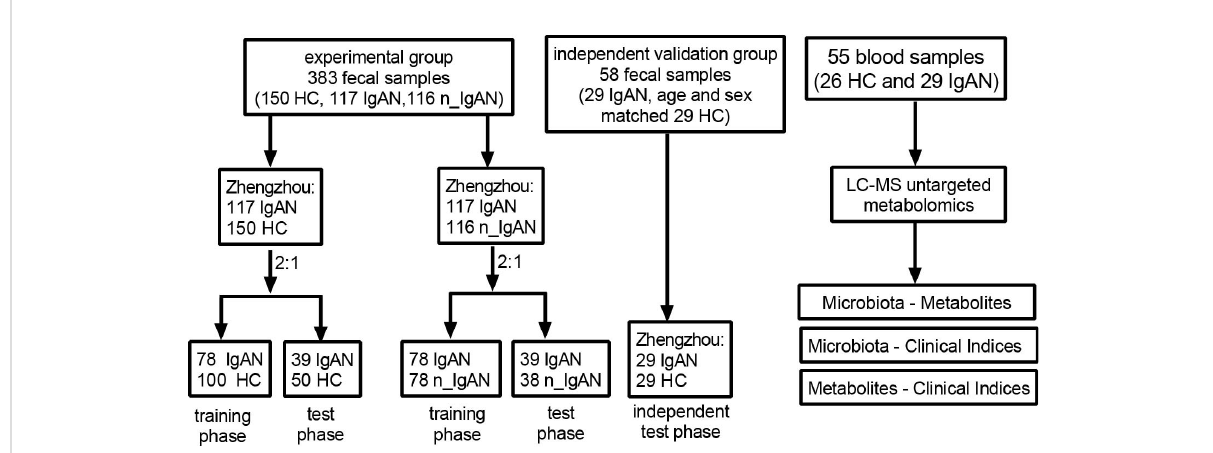
FIGURE 1 Flow chart of this study. Flow chart of disease diagnosis and differential diagnosis models based on fecal samples. In experimental group, 117 IgAN and 116 n_ IgAN fecal samples were collected from the biobank of the First Af fi liated Hospital of Zhengzhou University from May 24, 2018, to February 1, 2021. One-hundred-and- fi fty HCs fecal samples were collected from age- and sex- matched healthy volunteers. In independent validation group, 29 IgAN fecal samples were collected from the biobank of the First Af fi liated Hospital of Zhengzhou University from February 15, 2021 to July 31, 2021. And another 29 HCs fecal samples were collected from age- and sex- matched healthy volunteers. A total of 150 HCs and 117 IgAN fecal samples were randomly divided into the training phase (100 HCs and 78 IgAN patients) and test phase (50 HCs and 39 IgAN patients) at a ratio of 2:1. At a ratio of 2:1, 117 IgAN and 116 n_IgAN were randomly divided into the training phase (78 IgAN patients and 78 n_IgAN patients) and test phase (39 IgAN patients and 38 n_IgAN patients). Flow chart of analysis of association of microbiota, metabolites and clinical indicators through serum metabolomics studies. In the blood samples, 29 IgAN patients were from the independent validation group, while 26 HCs was sex- and age- matched healthy controls. HC, healthy controls; IgAN, immunoglobulin A nephropathy; n_IgAN, non-IgA nephropathy; LC-MS, Liquid Chromatography-Mass